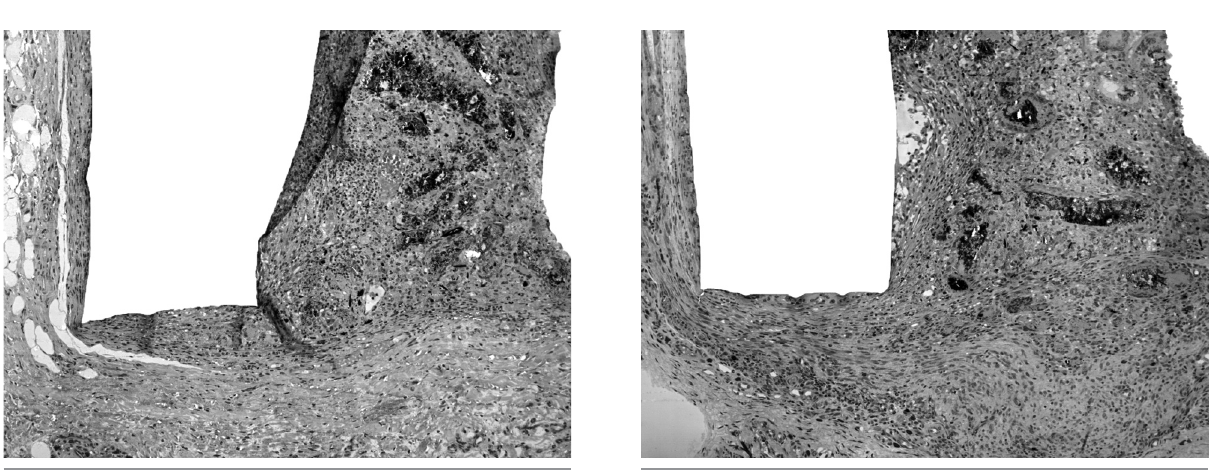
Figure 5. Inflammatory response in non-diabetic MTA Fillapex group at day 30: presence of a mild inflammatory cell infiltration consisting of macrophages and lymphocytes after 30 days (hematoxylin-eosin, 10X).